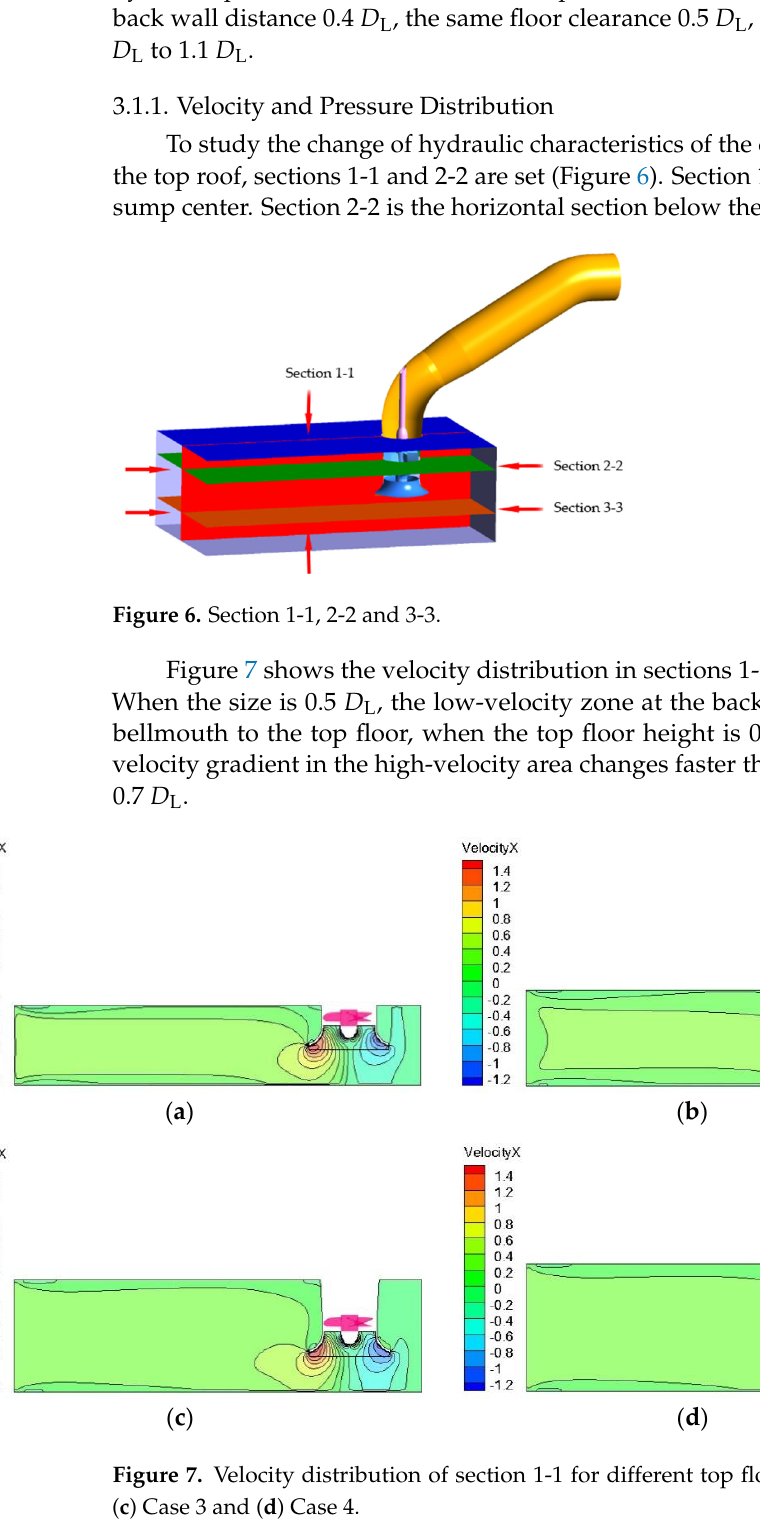
( d ) Figure 8. Pressure distribution of section 2-2 for different top floor height. ( a ) Case 1, ( b ) Case 2, ( c ) Case 3 and ( d ) Case 4.